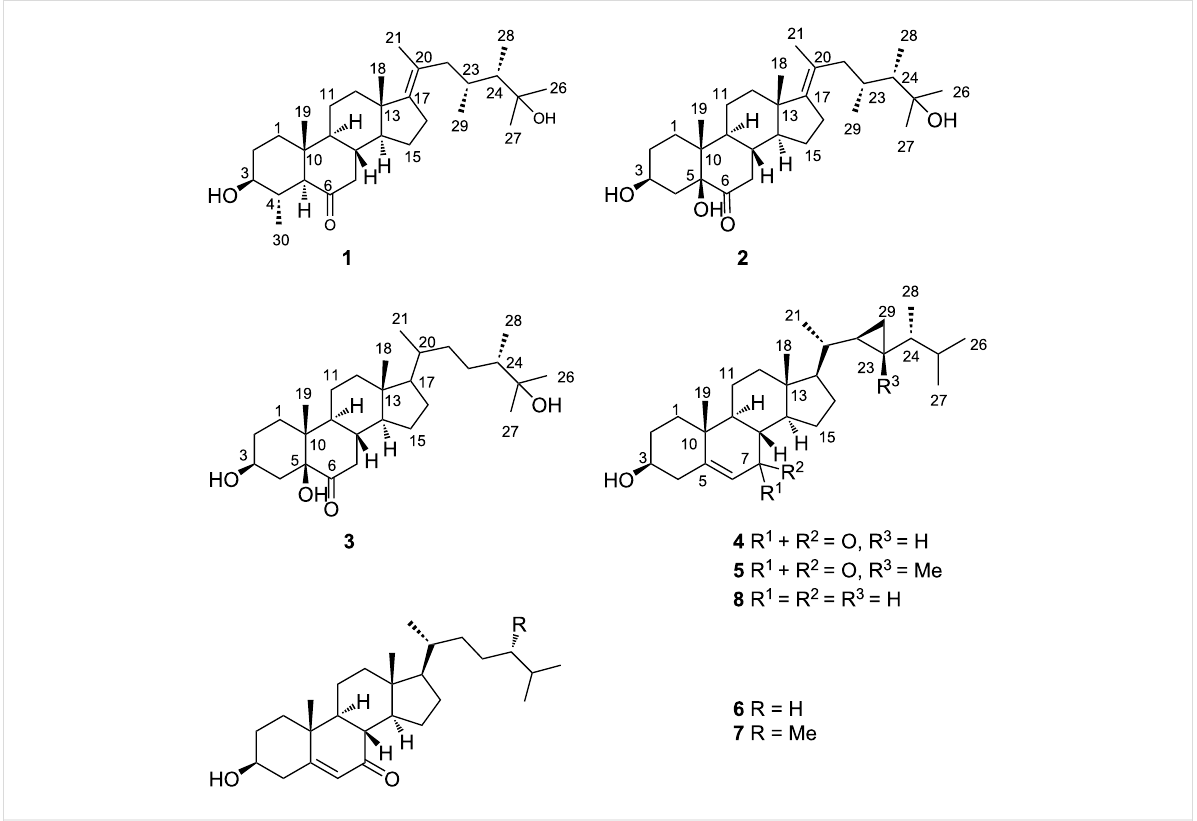
Figure 1: Structures of compounds 1 – 7